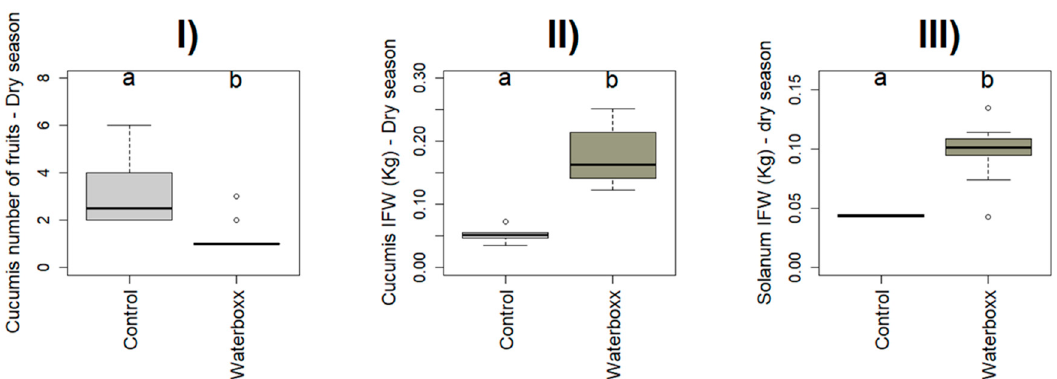
Figure 2. Significant effect of WST on crop’s plant traits from Floreana: Cucumis: ( I ) Number of Fruits—dry season, ( II ) IFW—dry season; Solanum : ( III ) IFW—dry season. Letters a and b represent